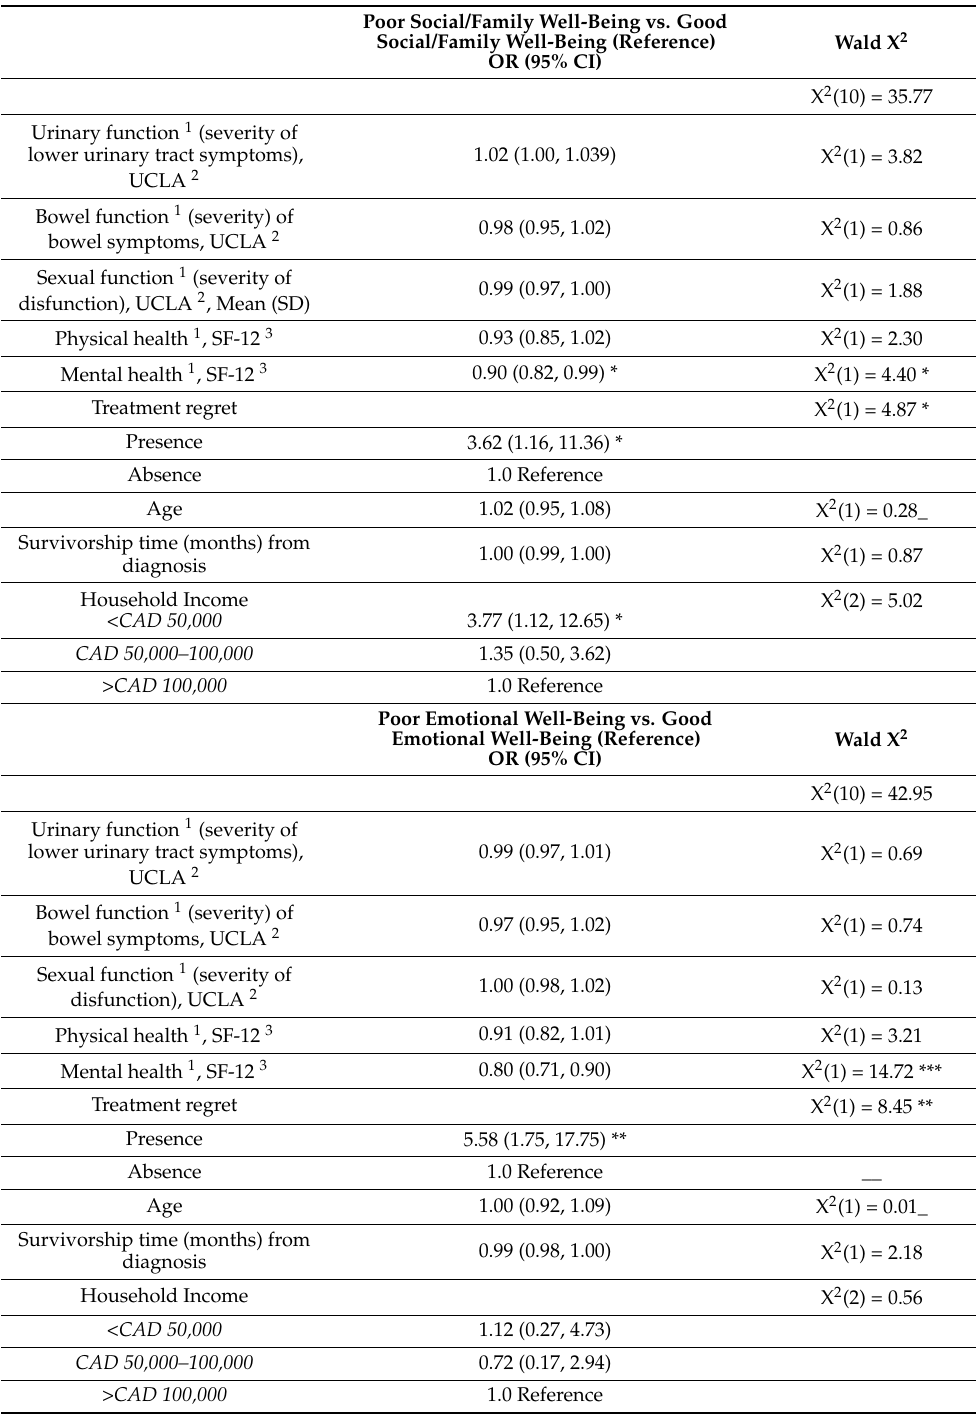
Table 2. Multivariate logistic regression assessing the relationship between social/family, emotional, functional and spiritual well-being outcomes and uro-oncological function, physical and mental health indicators, and demographic variables in a sample of men with a history of prostate cancer diagnosis from the baseline cycle of a Quality-of-Life Maritimes Survey administered between 2017 and 2020, n = 367. Poor Social/Family Well-Being vs. Good Social/Family Well-Being (Reference) Wald X 2 OR (95% CI) X 2 (10) =